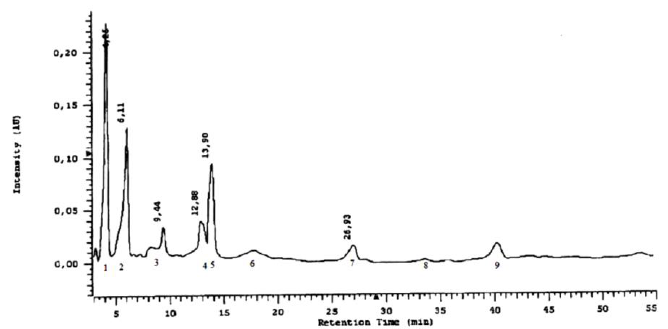
Figure 10. Separation of phenolic acids in methanol extract after basic hydrolysis in HPLC.